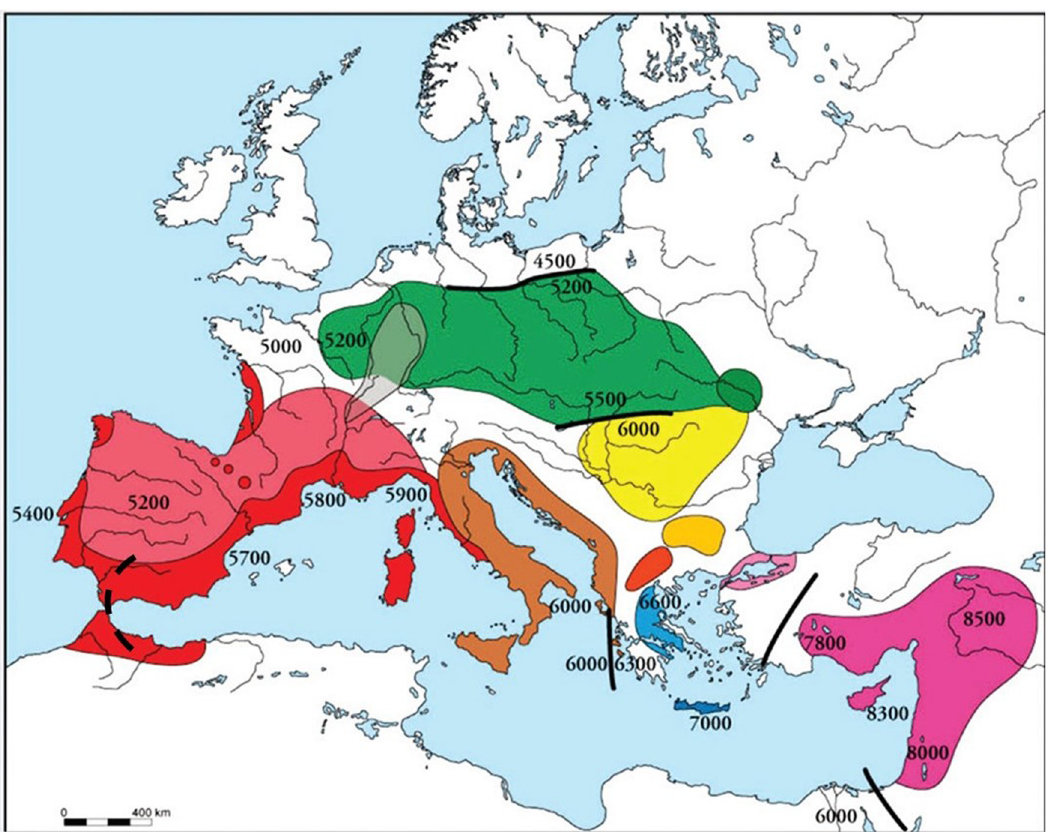
Figure 1: Near East and Neolithic Europe map. Coloured areas represent di ff erent Neolithic cultures, and black solid lines represent the areas where cultural and chronological recomposition occurs, according to Guilaine ( 2001 ) . The original map was modi fi ed to include the Mediterranean/Atlantic transition around the Strait of Gibraltar – dotted line. This last Western recomposition does not correspond to a chronological gap between Iberia Mediterranean/Atlantic façades, as documented in other European